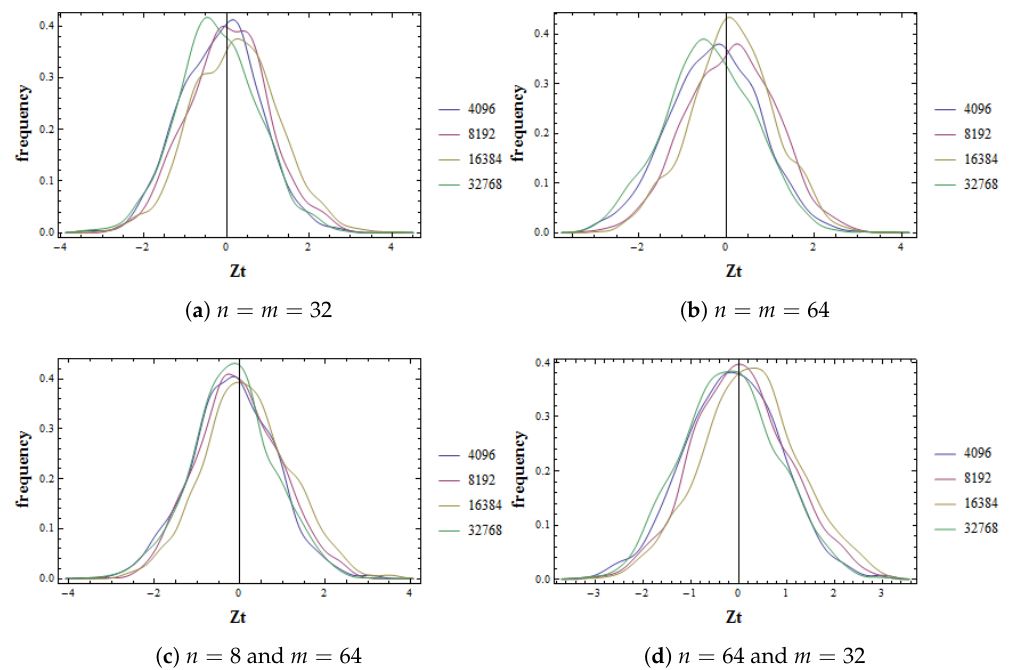
Figure 1. Observed distribution of 1000 values of Z T in random H i matrices for various values of n , m , and l .